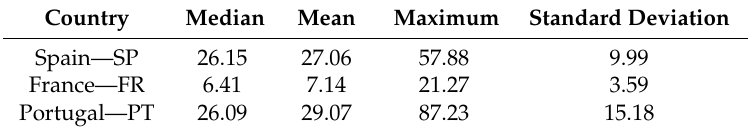
(cid:0) (cid:1) E RE / E h , for the year 2017. h Standard Deviation